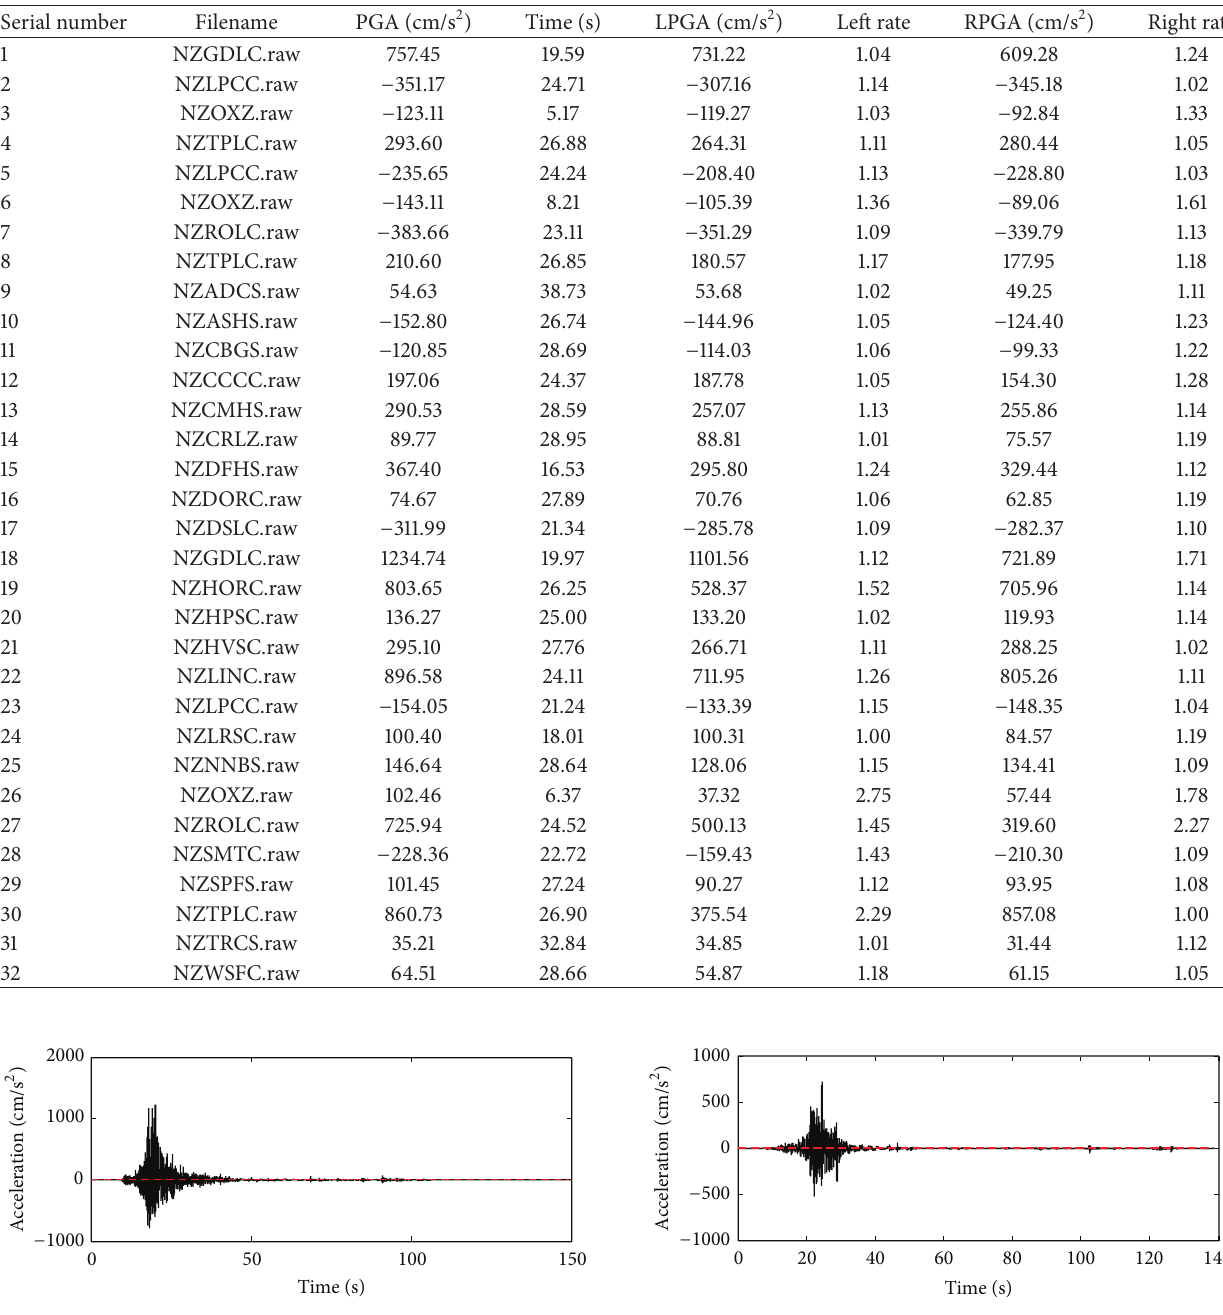
Table 2: Records with ratio of PGA to adjacent points greater than 1.1 in New Zealand Mw7.0 earthquake.